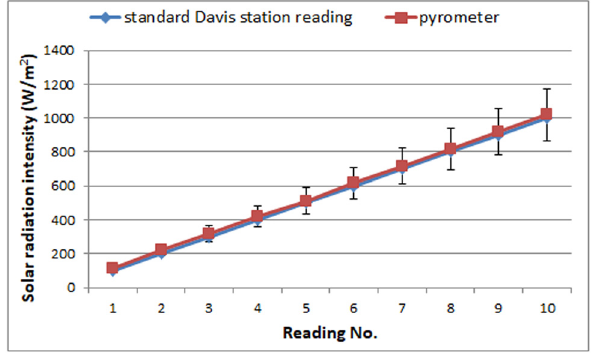
± 0.3% and / 0.1–89 m s with accuracy of ± 5% , respec - tively. Figures 5 and 6 show the reading error ratio for the pyrometer and anemometer, respectively.